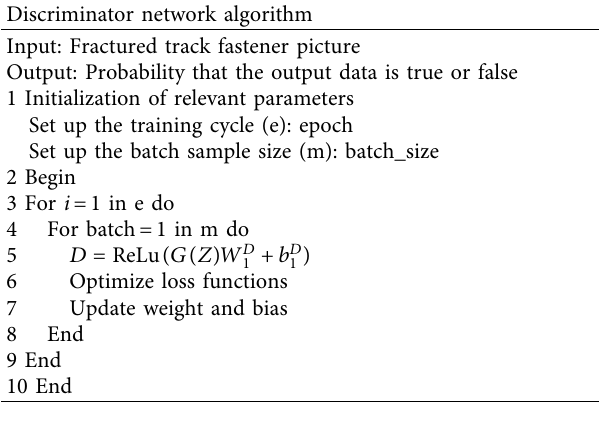
Table 3: Discriminator network algorithm. Discriminator network algorithm